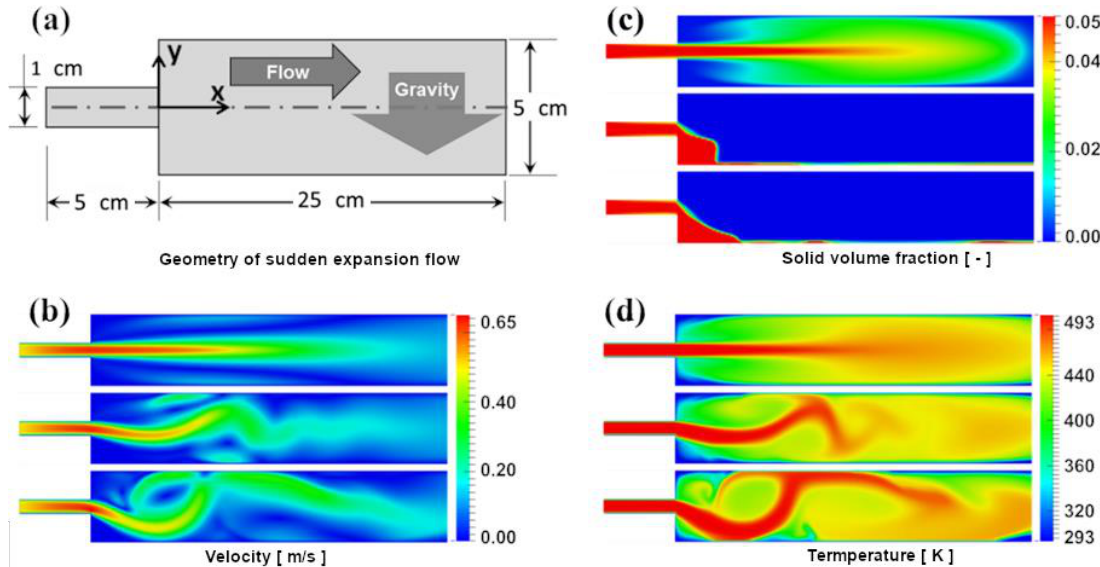
Figure 2. ( a ) Schematic of the straight sudden expansion channel; ( b ) The velocity distribution; ( c ) The volume fraction distribution of the solid particles; ( d ) The temperature distribution. For the panel ( b – d ), from top to bottom the three different fields are simulation results by: 1. Phillips’ model [14] without considering gravity; 2. Phillips’ model [14] considering the gravity; 3. Proposed particle flux model considering gravity. All the fields are the acquired at t = 2 s.